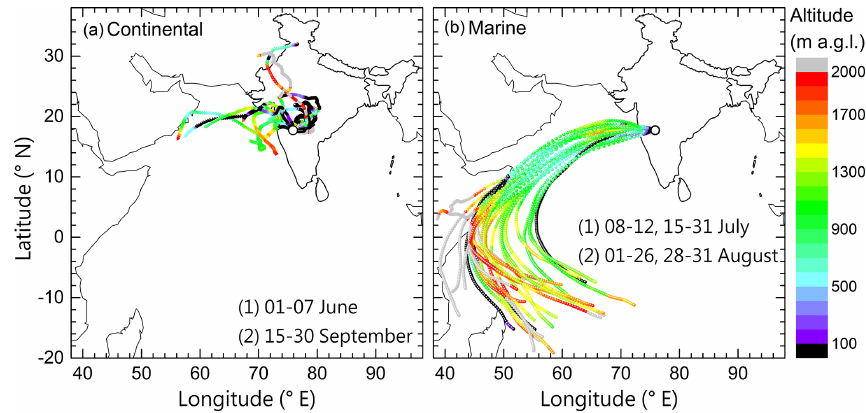
Figure 1. Air mass back trajectories with 5d duration reaching 50m above the site segregated to (a) continental and (b) marine. The color of the trajectories indicates the altitude of the air mass above ground level